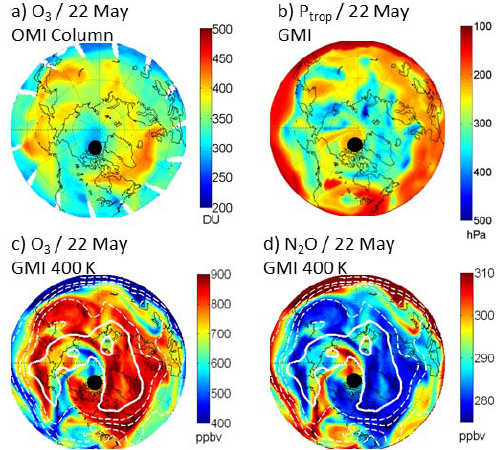
Fig. 10. Formation of ozone mini-hole above Eureka: (a) OMI ozone total columns (DU), (b) GMI tropopause pressure (hPa), (c) GMI ozone VMR at 400 K, and (d) GMI N 2 O VMR at 400 K ( ∼ 13km). For ozone and N 2 O, low [high] VMRs are given in blue [red]. The color scale for the tropopause pressure is reversed so that low pressures (high altitudes) are in red and high pressures (low alti- tudes) are in blue. The white contour lines indicate the geopotential height, with thick lines indicating 13.4 and 13.6km and thin dashed lines indicating > 13.6km on 0.2-km intervals. Eureka is indicated by the black